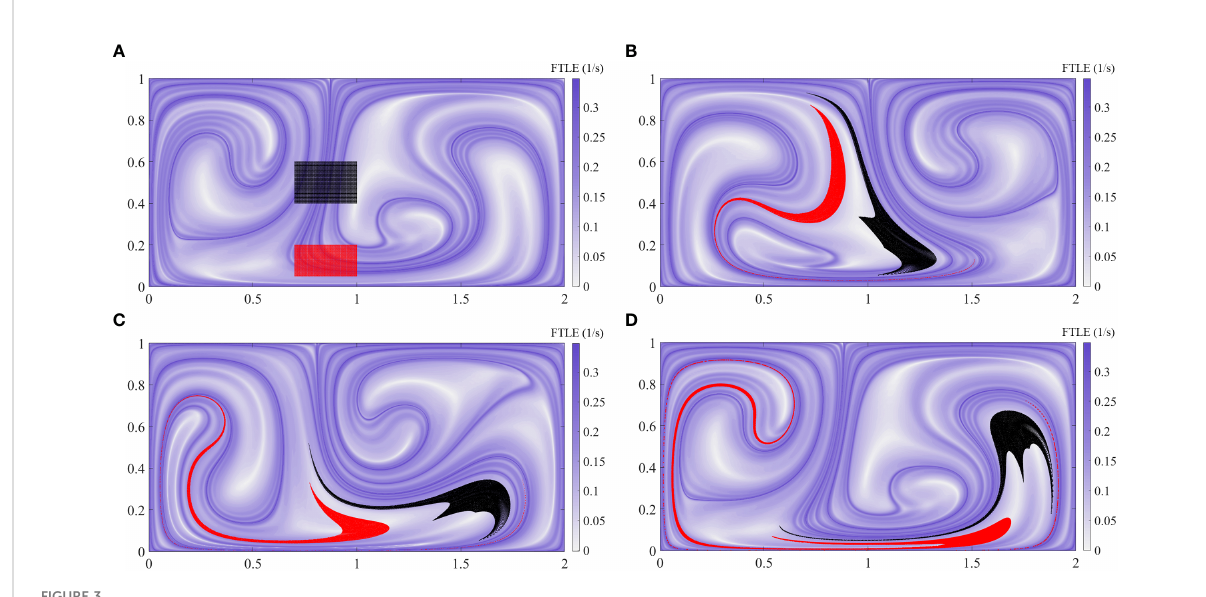
FIGURE 3 Plot of tracer particles injected at t = 0 s (A) and position of the particle at t = 16 s (B) , 18 s (C) , and 20 s (D) , superimposed aLCSs at the corresponding time on the base